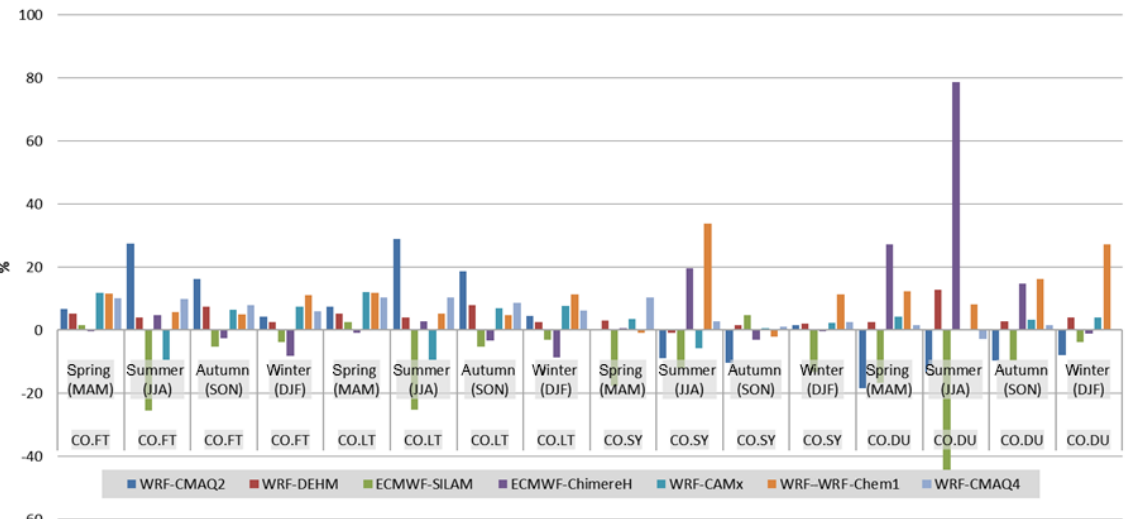
Figure 11. RMSE variation between the s20% scenario (anthropogenic emission and boundary condition reduced by 20%) and the base case for CO in